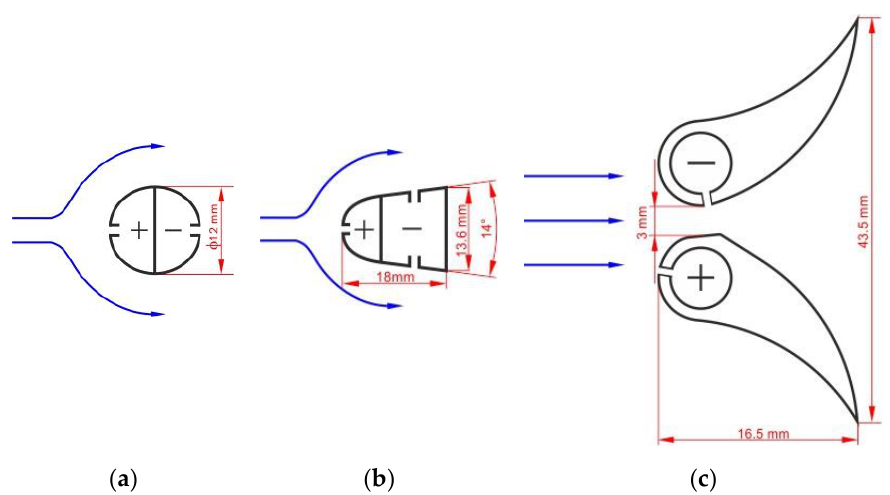
Figure 2. Averaging cross-sections of the Pitot tube. ( a ) circular, ( b ) streamlined, ( c ) two profile.